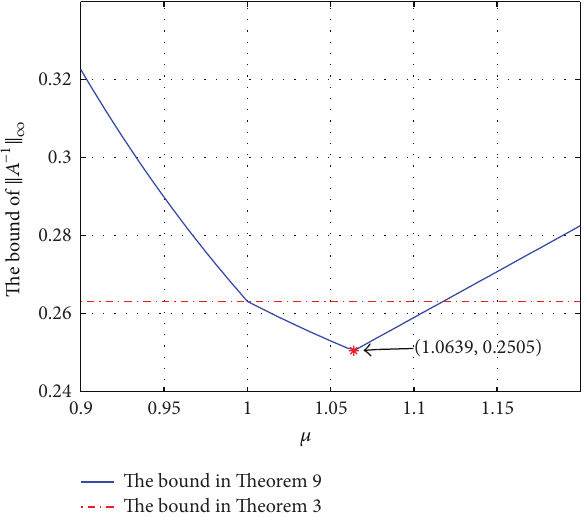
Figure 1: The bounds in Theorems 9 and